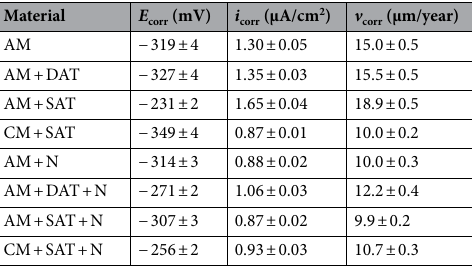
Table 1. Electrochemical parameters determined from the potentiodynamic